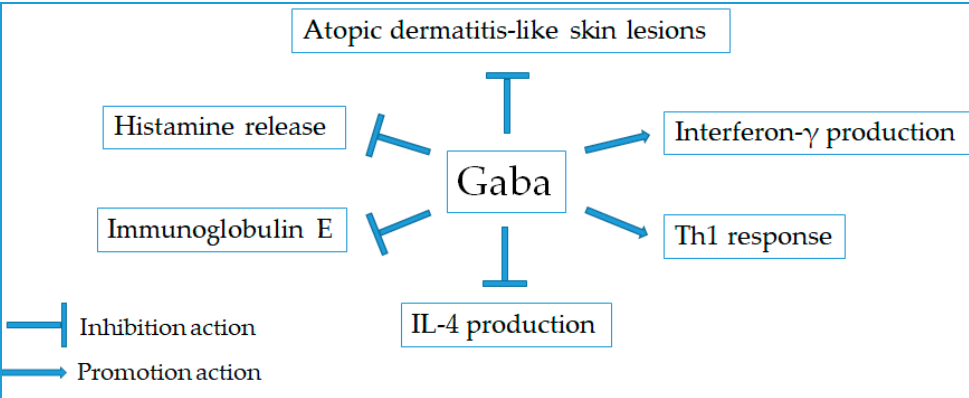
Figure 6. Therapeutic targets for anti-allergic activity of Gaba.